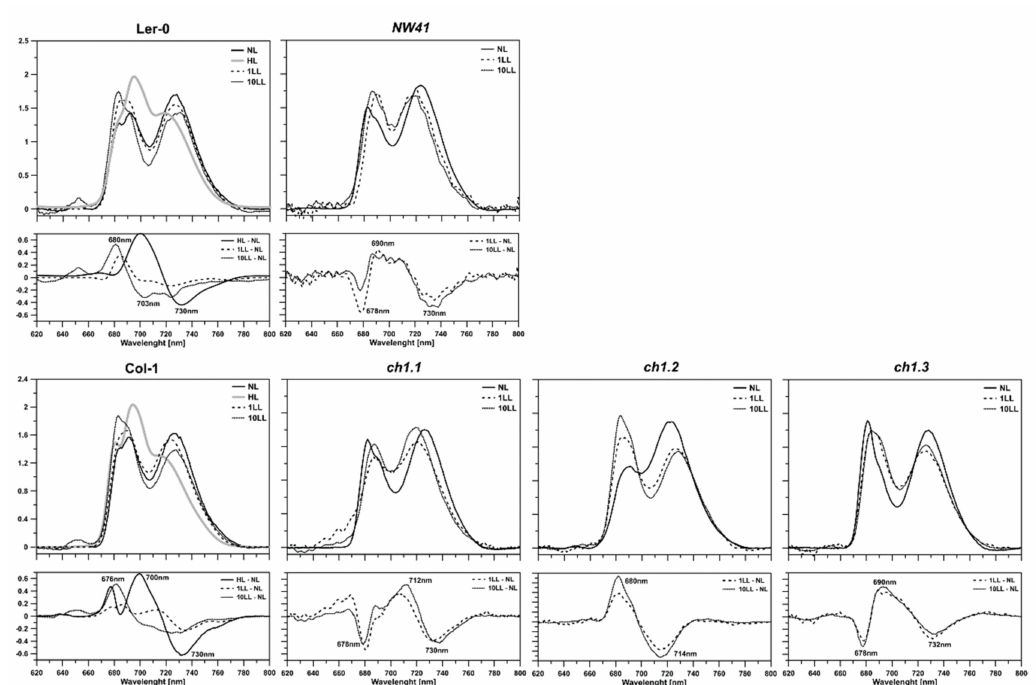
Figure 3. Spectroscopic analysis of thylakoids isolated from NW41, ch1.1 , ch1.2 , ch1.3 , Ler-0 and Col-1 Arabidopsis plants in NL (normal light), LL (low-light) and HL (high-light) conditions; 1LL, 10LL—after 1st and 10th day of treatment. Fluorescence emission spectra at 77K, excited at 470 nm, Chl concentration of 10 µ g/mL in 20 mM HEPES-NaOH buffer (pH 7.5) containing 15 mM NaCl, 4 mM MgCl 2 and 80% ( v / v ) glycerol. The spectra were normalized to the area of 100 under the spectrum. The presented spectra are representative of three separate experiments. Fluorescence emission at 685 and 695 nm corresponds to the PSII core and inner antenna, at 730 and 695 nm to the PSI core and inner antenna, at 681 to the LHCII trimers (outer PSII antennae) and at 700 nm to LHCII